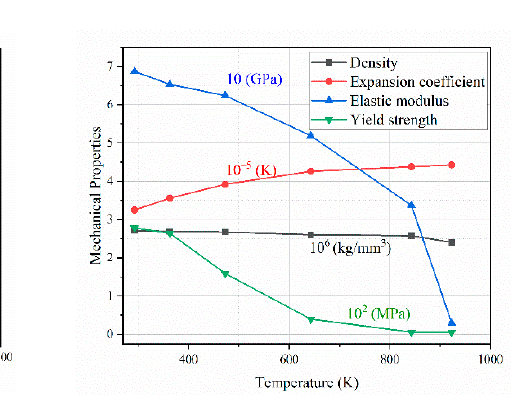
Figure 2. Temperature-dependent properties for 6061-T6. Table 1. Chemical composition of 6061A-T6 (wt.%).